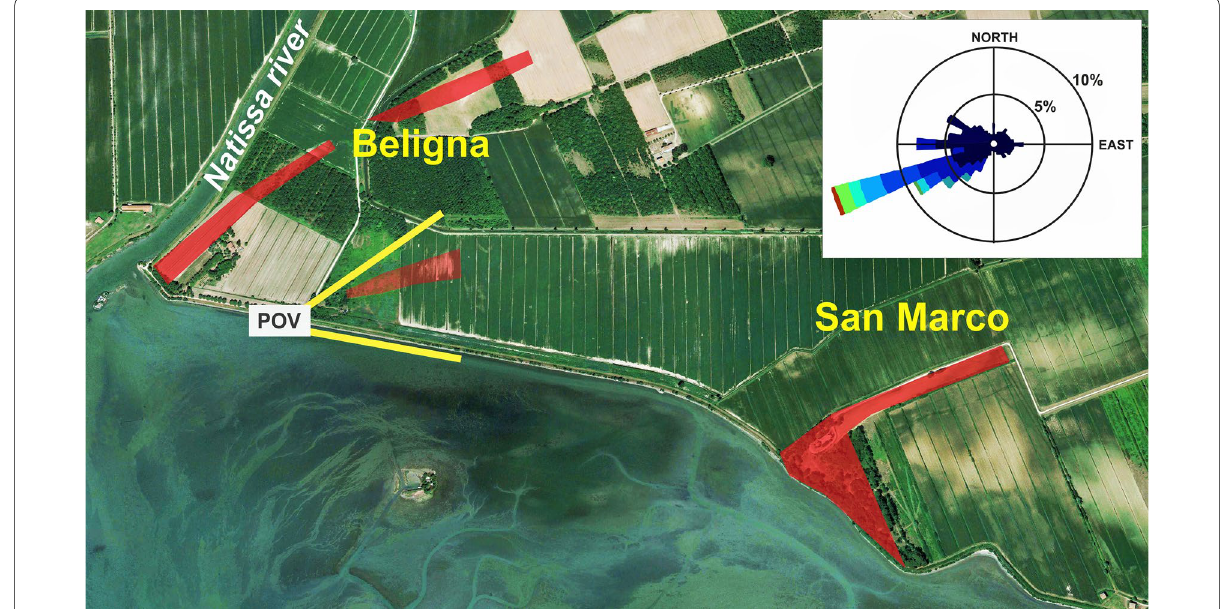
Fig. 23 Beligna and San Marco dunes together with the identified peat channels. Also shown the wind rose diagram that highlights the dominant wind ( Bora ) (Bellafiore et al. 2012) and the Point of View (POV) of the aerial photo in Fig. 19b (the yellow lines show the approximate field of view). The presence and direction of the delineated peat channels is confirmed by a series of further seismic data recorded all over the area and not reported for the sake of